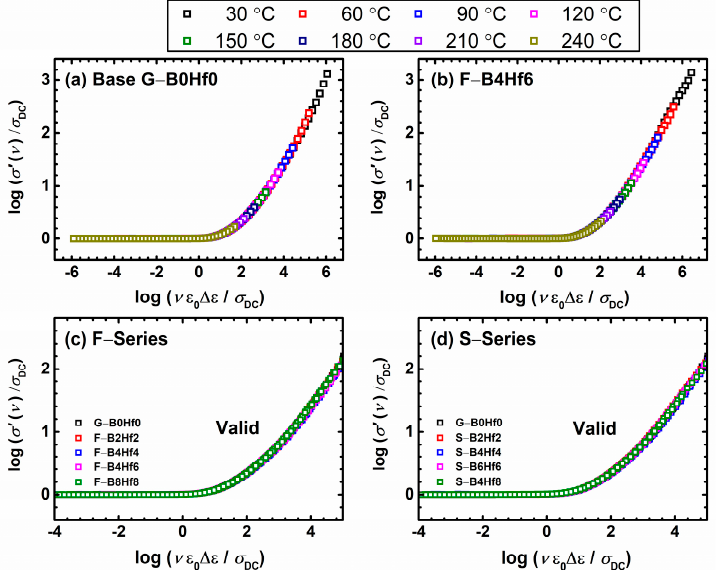
Figure 8. Conductivity spectra scaled according to Sidebottom scaling procedure for ( a ) base G–B0Hf0 and ( b ) F–B4Hf6 samples and ( c , d ) construction of super-master curve of the conductivity isotherms using Sidebottom scaling procedure.